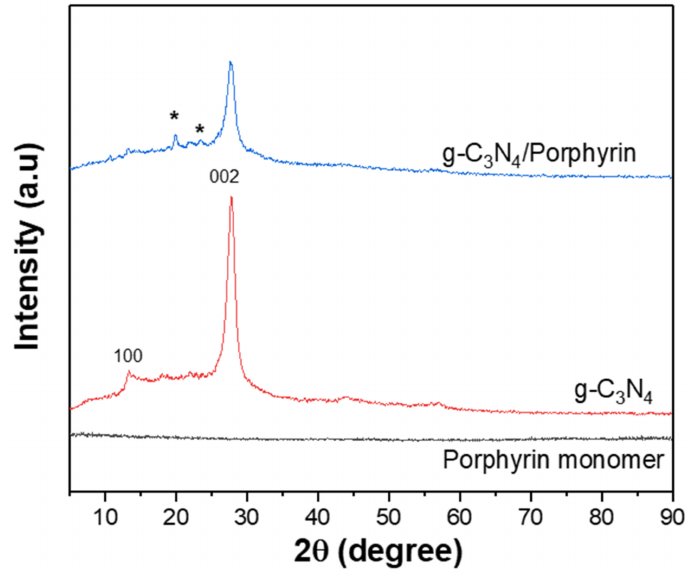
Figure 4. XRD patterns of TCPP porphyrin monomer, g-C 3 N 4 , and g-C 3 N 4 /porphyrin